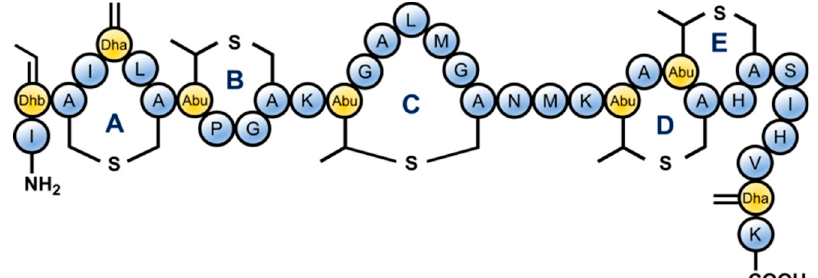
Figure 1. The structure of nisin. Classified as a lantibiotic due to the presence of unusual lanthionine rings in its structure, nisin also contains unsaturated amino acids introduced by posttranslational modifications: Dhb = dehydrobutyrine, Dha = dehydroalanine and Abu = aminobutyric acid.